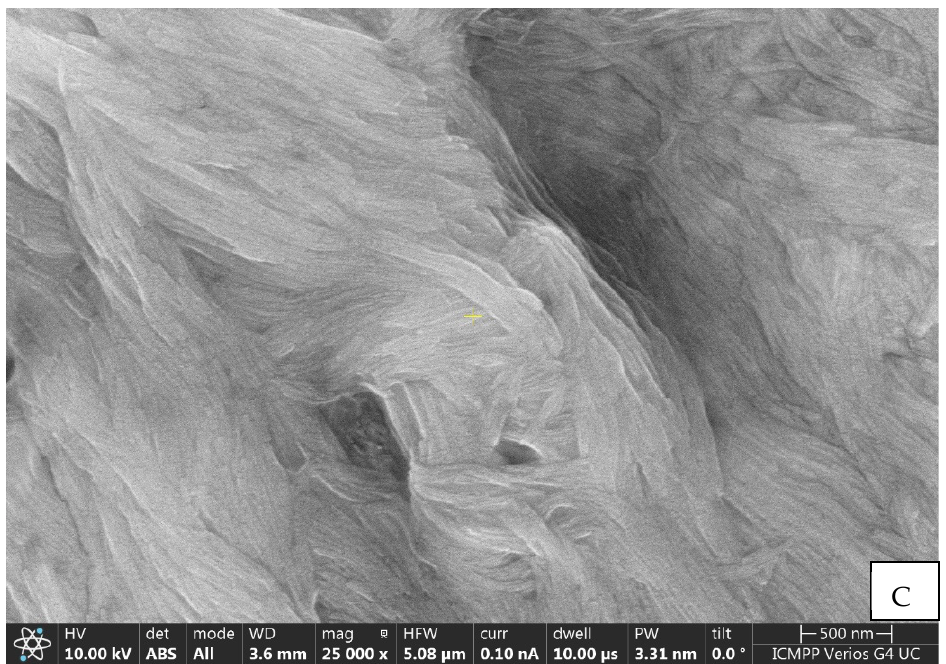
Figure 5. Scanning electron micrograph at different magnifications representing the active surface of GO-Peptide/SPCE: ( A ) 2000 times magnification; ( B ) 10,000 times magnification; ( C ) 25,000 times magnification.